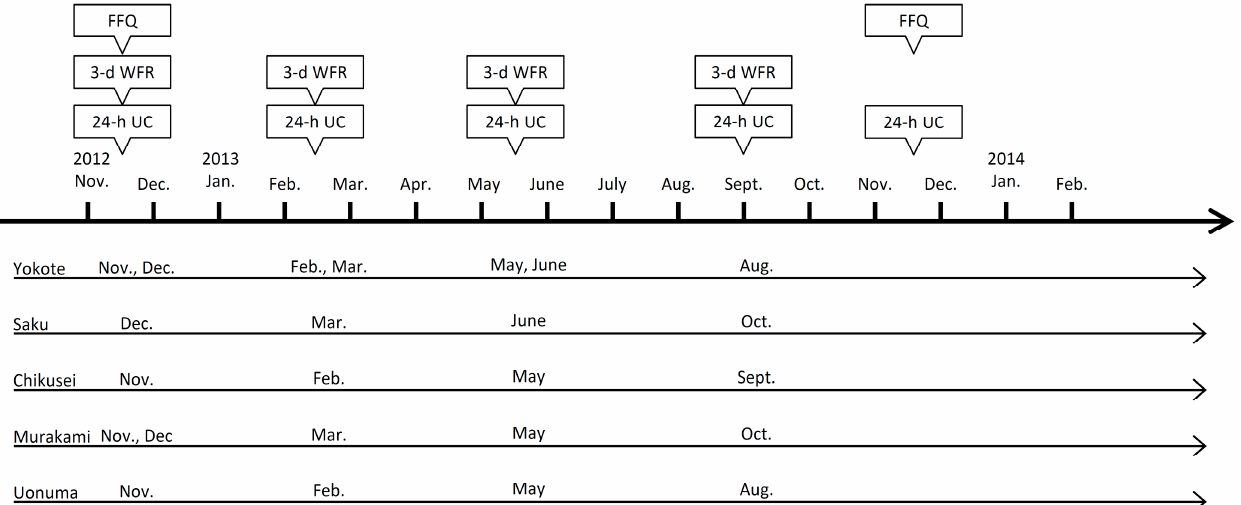
Figure 1. Data collection sequence in the validation study. d, days; FFQ, Food Frequency Question- naire; WFR, weighted food record; UC, urinary collection.